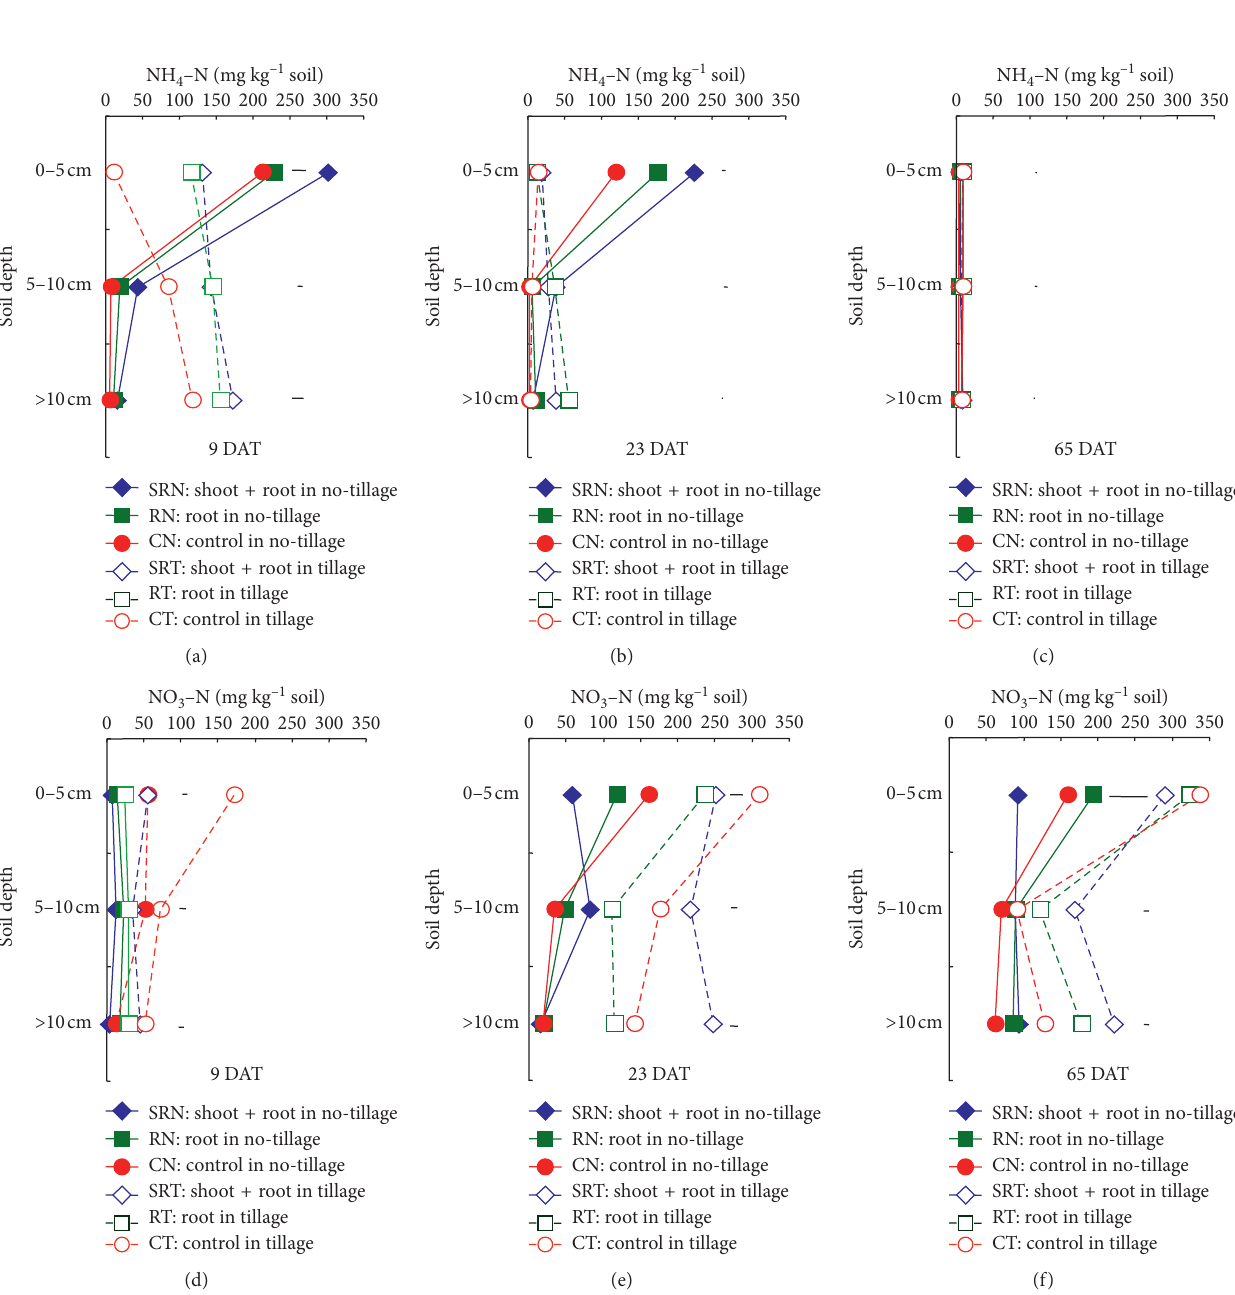
Figure 1: Ammonium-N and nitrate-N levels distributed in three soil depths (0–5cm, 5–10cm, and > 10cm) at 9, 23, and 65 days after treatment (in absence of corn), shoot and root addition (SRN and SRT), root addition (RN and RT) and without hairy vetch addition in no- tillage (CN) and tillage (CT). Vertical bars represent LSD ( p < 0 .